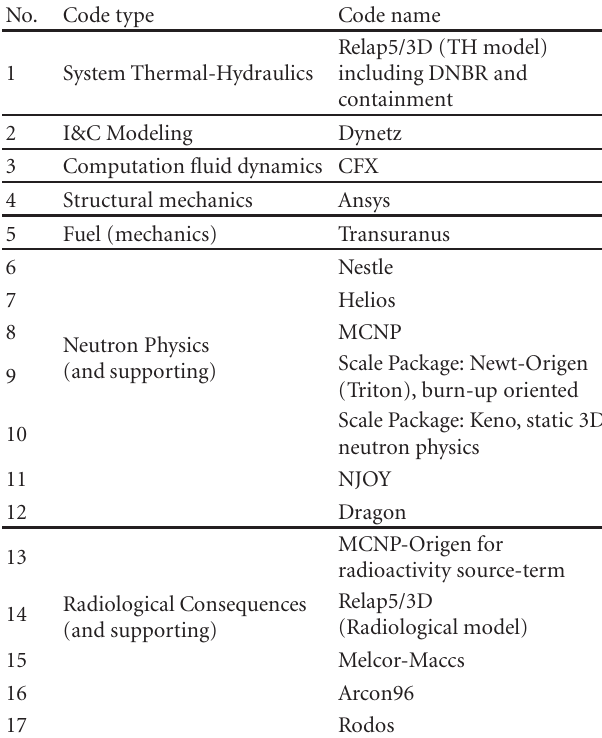
Table 3: List of codes used for BEPU accident